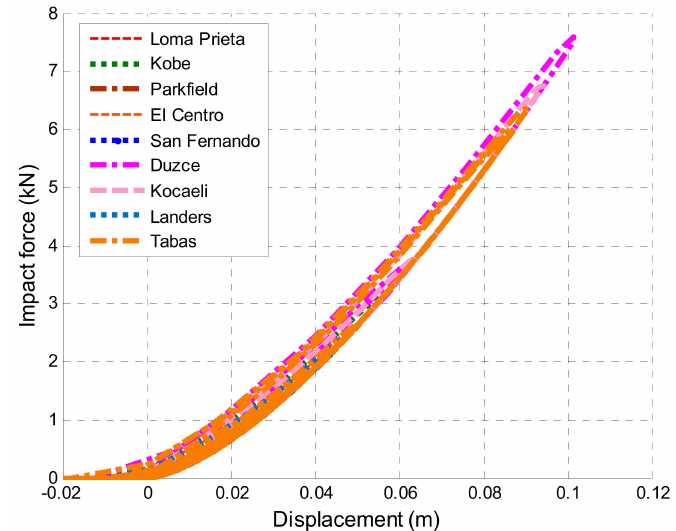
Figure 3. Impact forces with relation to impact displacement under di ff erent